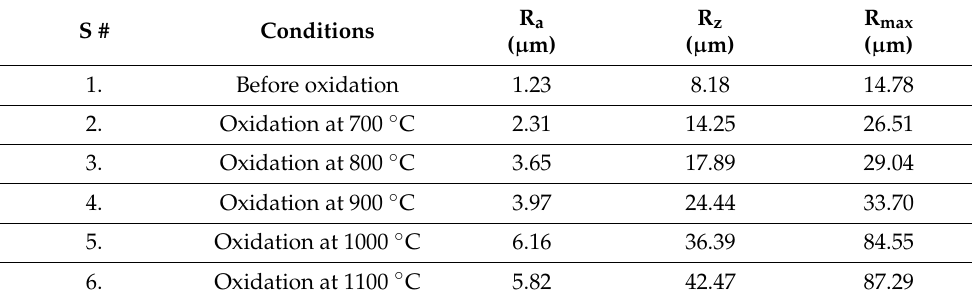
Table 6. Roughness values before oxidation and after oxidation.